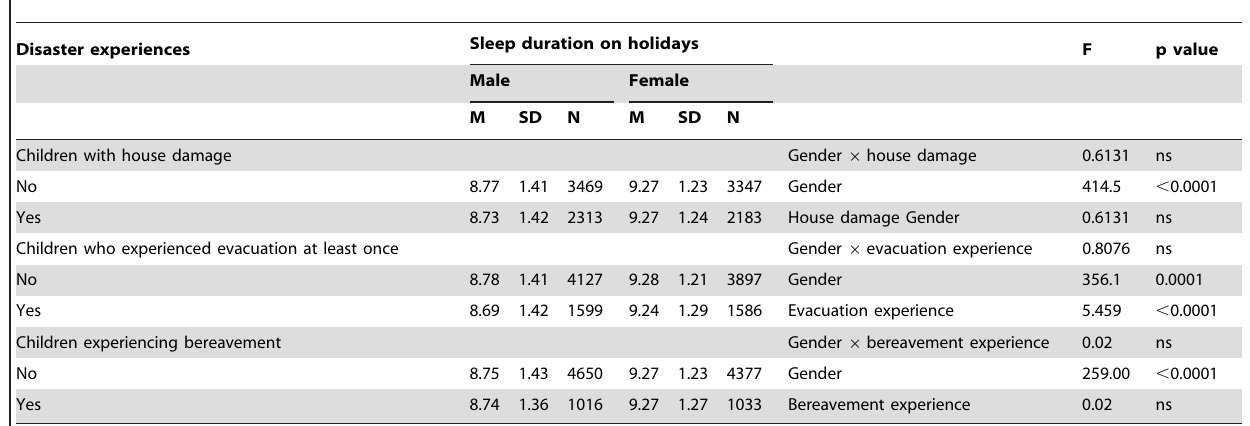
Table 8. Average sleep duration on holidays (number of disaster experiences and